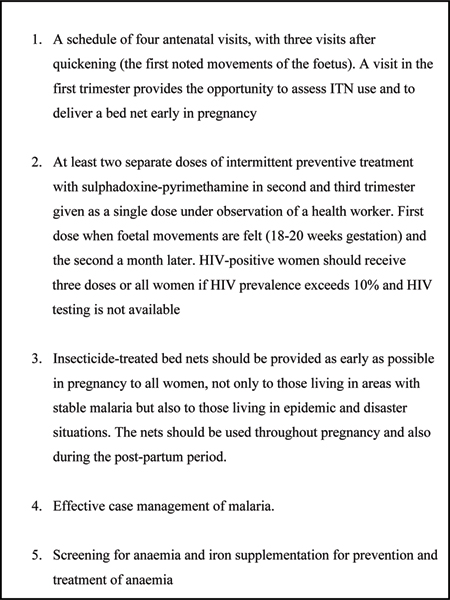
Recommended interventions for malaria control during pregnancy for women living in areas with stable transmission. Source: World Health Organization [1].